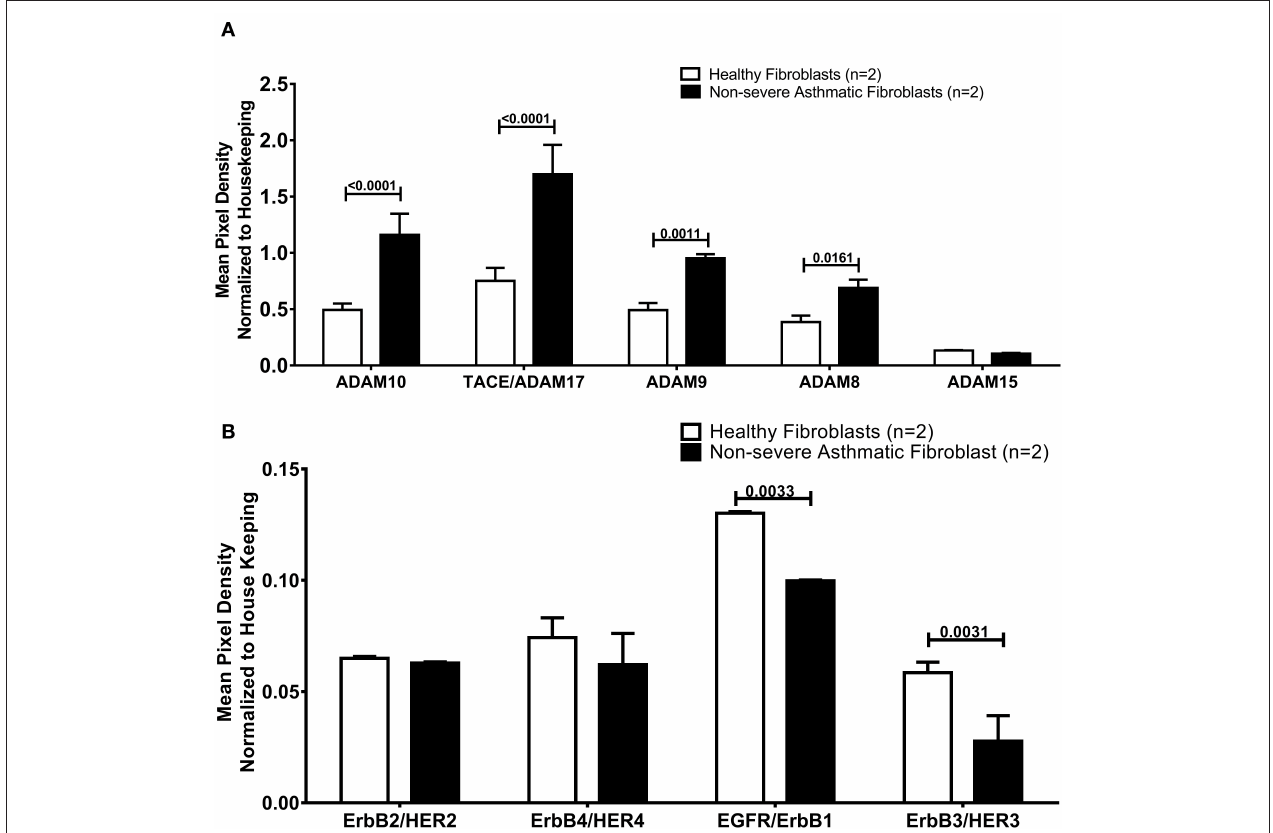
FIGURE 6 | Levels of soluble receptors shed in the conditioned media of healthy and non-severe asthmatic fibroblasts using non-hematopoietic and the common analytes array. (A) Protein expression of AREG shredders: ADAM 8, 9, 10, 15, and 17 in non-severe asthmatic fibroblasts compared to healthy fibroblasts. (B) Protein expression of shed ErbBl-4/HER1-4 in non-severe asthmatic fibroblasts compared to healthy fibroblasts. TABLE 6 | Summary of in silico and in vitro analysis of AREG mRNA expression in different settings of asthma. GenesBronchial